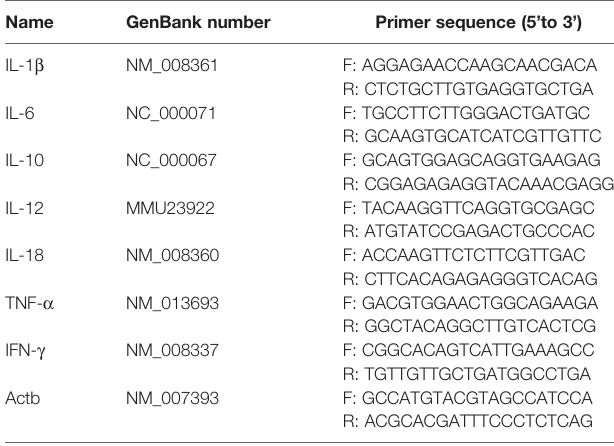
TABLE 1 | qPCR primer sequences of in fl ammatory cytokines.